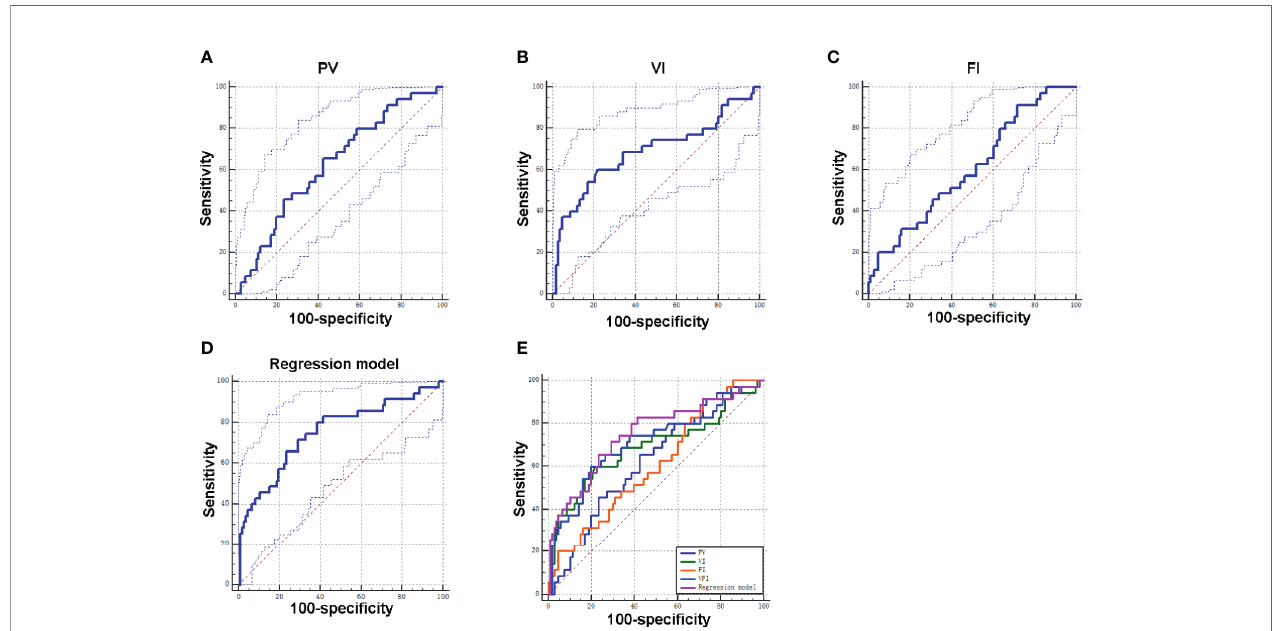
FIGURE 3 | Diagnostic values of PV, VI, FI, and VFI for GDM. (A) ROC curve of PV for distinguishing GDM patients from non-GDM patients. (B) ROC curve of VI for distinguishing GDM patients from non-GDM patients. (C) ROC curve of FI for distinguishing GDM patients from non-GDM patients. (D) ROC curve of integrated factors using regression model for distinguishing GDM patients from non-GDM patients. (E) ROC curves of individual factor and integrated factors for distinguishing GDM patients from non-GDM